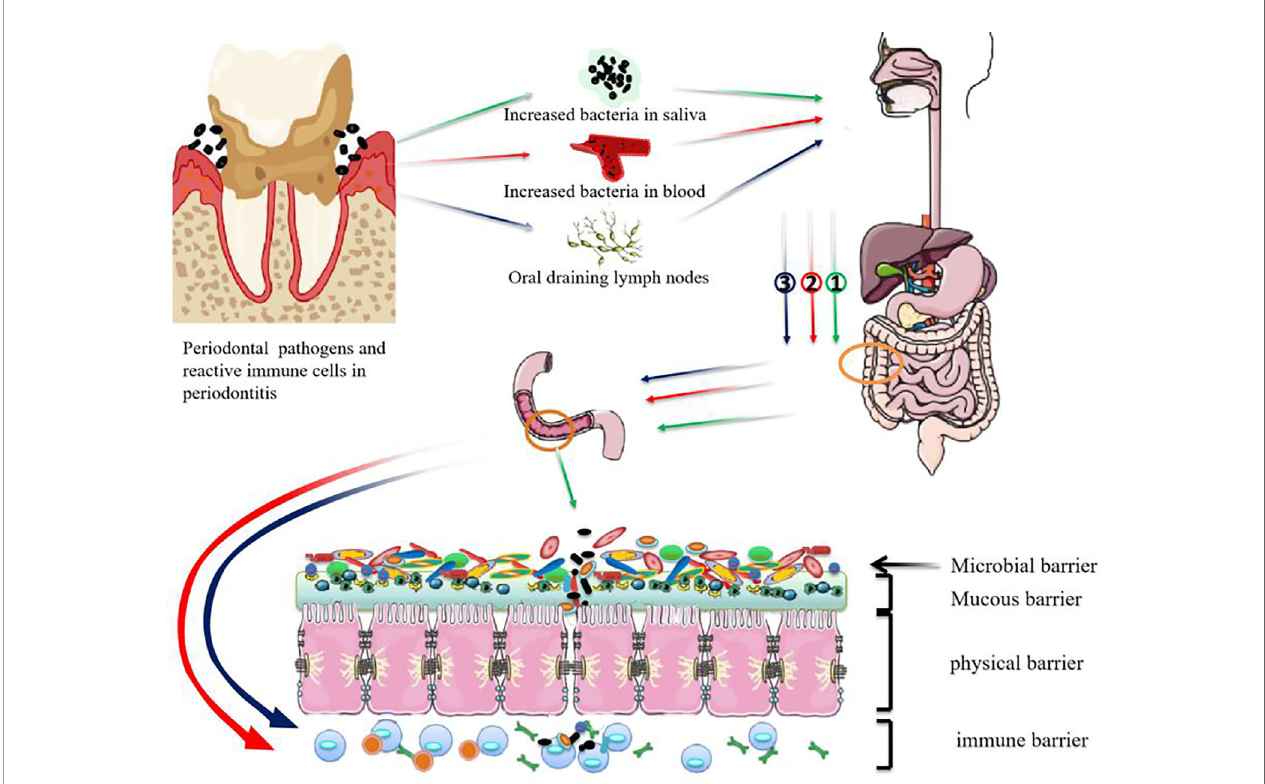
FIGURE 1 | Possible mechanisms for periodontal pathogens damaging the intestinal barrier. ① Swallowed periodontal pathogens may transmigrate to the lower gastrointestinal tract and disrupt intestinal homeostasis. ② periodontal pathogens may disseminate to intestinal tissues through the bloodstream and take part in the progression of intestinal diseases. ③ Pathobiont-reactive immune cells activated by periodontal pathogens may transmigrate from the oral draining lymph nodes to the gut where they activate intestinal immune